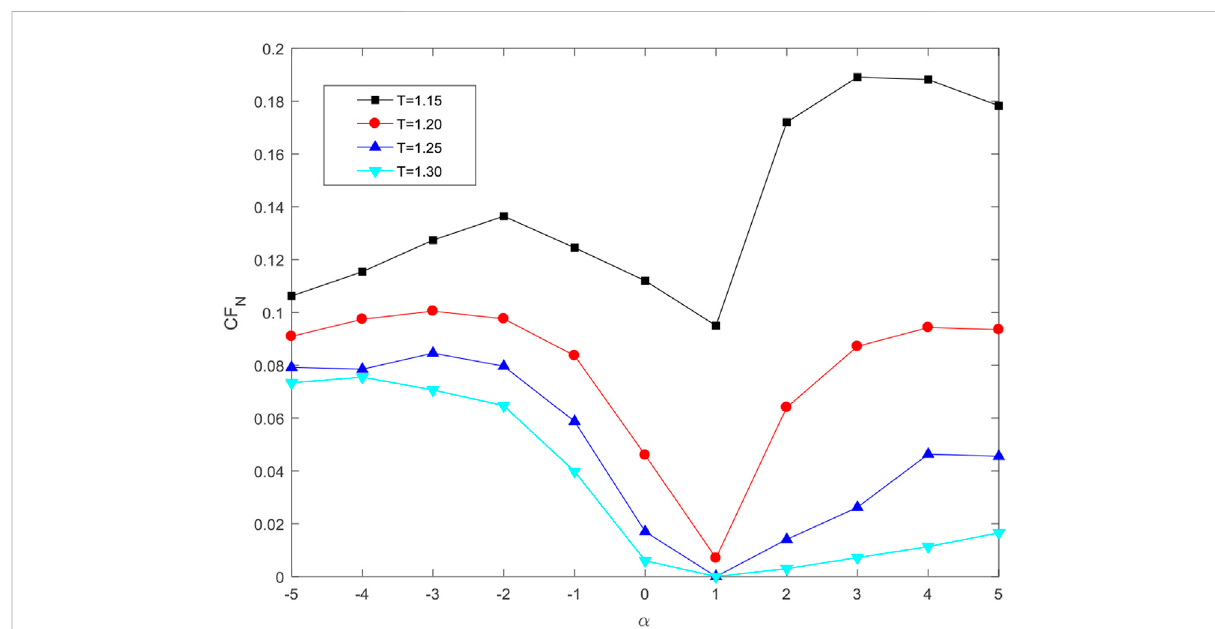
FIGURE 3 Effect of parameter α on the cascading failures performance. β (cid:1) 1 in the simulations.